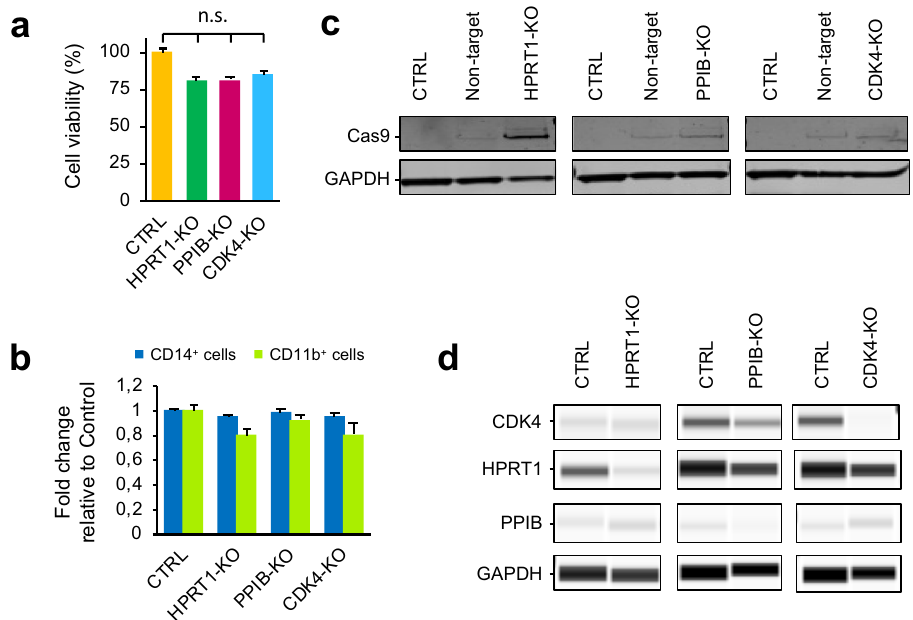
Figure 1. iPSC-derived macrophage knock-out targeting three macrophage non-essential genes: HPRT1; PPIB and CDK4. ( a ) Percentage of cell viability (±SEM) in iPSC-derived macrophages 3 days after transduction with pool of 4 sgRNAs of HPRT1, PPIB and CDK4 lentiviruses. CTRL sample are cells after spinfection with PB and Vpx. ( b ) Fold change (±SEM) of CD14+ and CD11b+ iPSC-derived macrophages 14 days after transduction with HPRT1, PPIB and CDK4 lentiviruses. ( c ) Western blot analysis of Cas9 protein in CRISPR/Cas9-transduced iPSC-derived macrophages. GAPDH loading control. ( d ) Detection of HPRT1, PPIB and CDK4 in capillary western blot (Wes) assay in transduced iPSC-derived macrophages (MOI 3). GAPDH loading control. Full length gels and blots are included in Supplementary Figs. S5 and S6. Capillary Wes images were obtained from Compass for SW 5.0.1. software. https ://www.prote insim ple.com/compa ss. n.s. non-significant